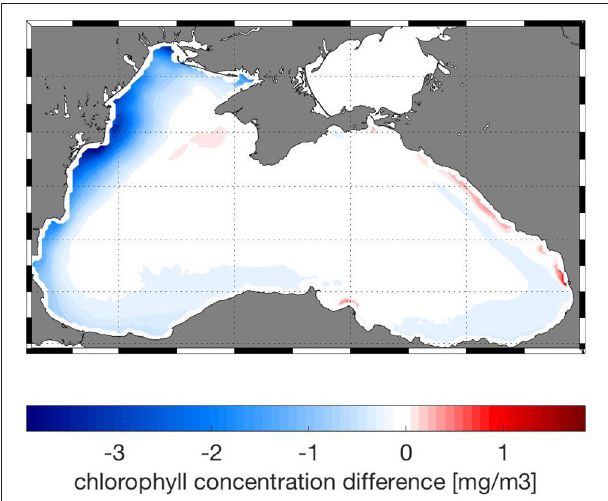
FIGURE 6 | Absolute difference between model and satellite chlorophyll concentrations averaged over 5 years (2010–2014) in